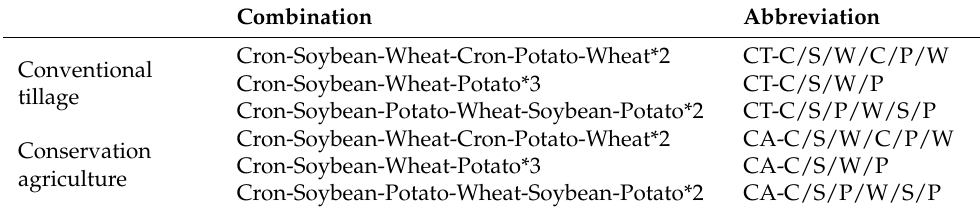
Table 1. Crop rotation combination from 2039 to 2050.